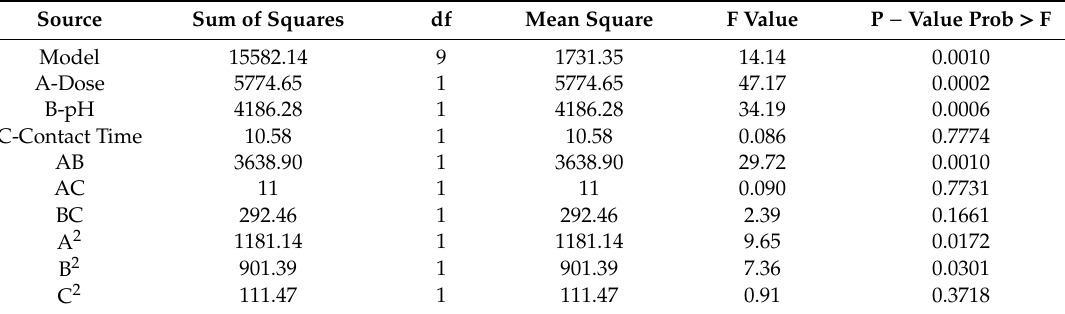
Table 5. ANOVA for Al 3 + capacity of hybrid